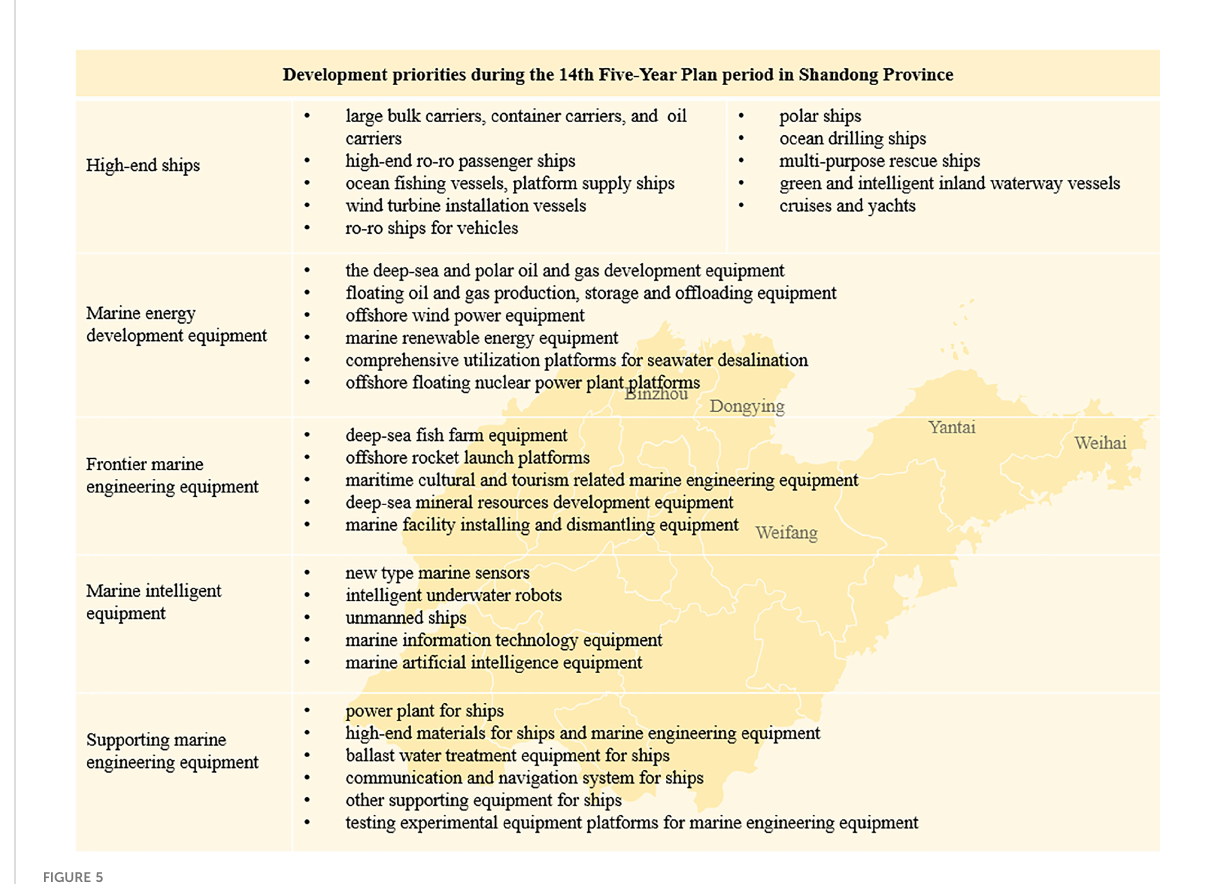
FIGURE 5 Development priorities during the 14th Five-Year Plan period in Shandong Province. Source: Authors ’ compilation based on MEE policies in Shandong Province ’ s 14th Five-Year